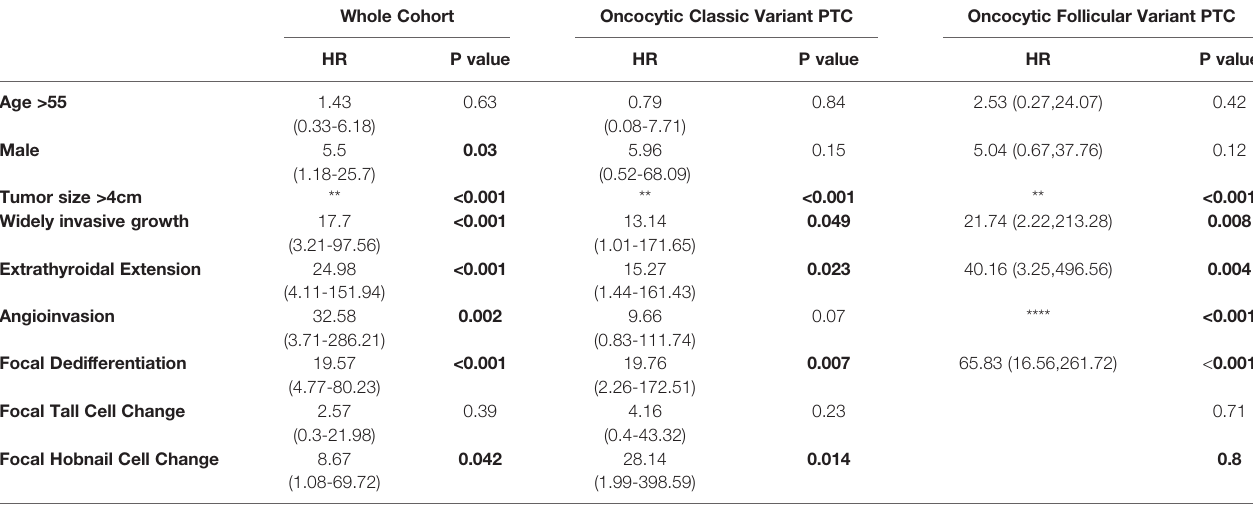
TABLE 3 | Univariate analysis offactors associated with distant metastases in patients with oncocytic classic variant and oncocytic follicular variant papillary thyroid carcinoma.